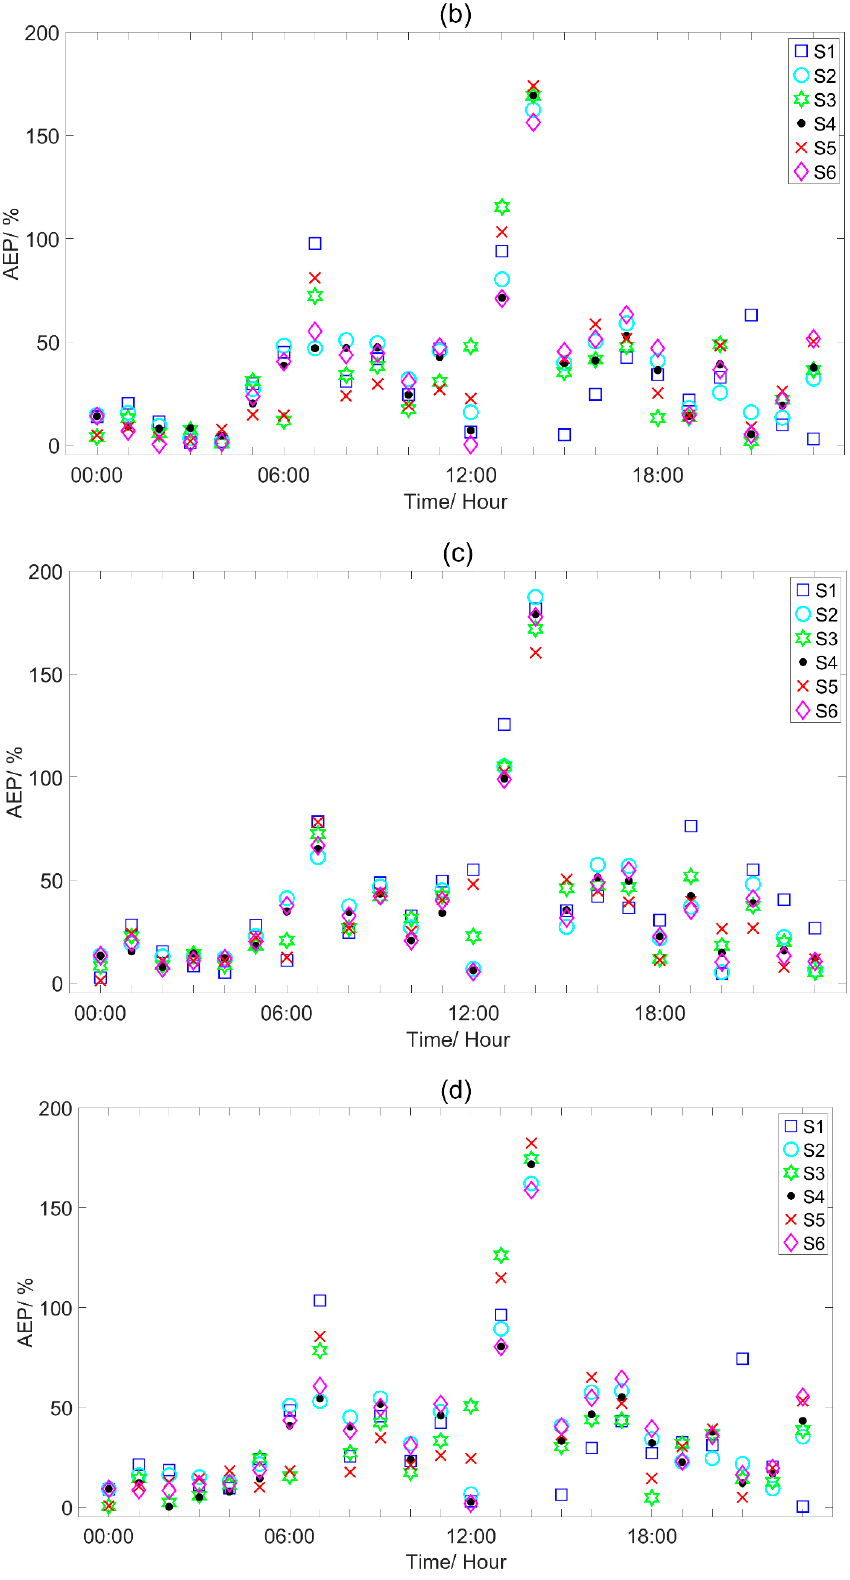
Figure 10. Same as Figure 9, but for distributions of hourly AEPs.( a , b ) are the results of 30 m, ( c , d ) are the results of 60 m. ( a , c ) are the simulation results with the GFS as the initial data; ( b , d ) are the simulation results with the ERA5 as the initial